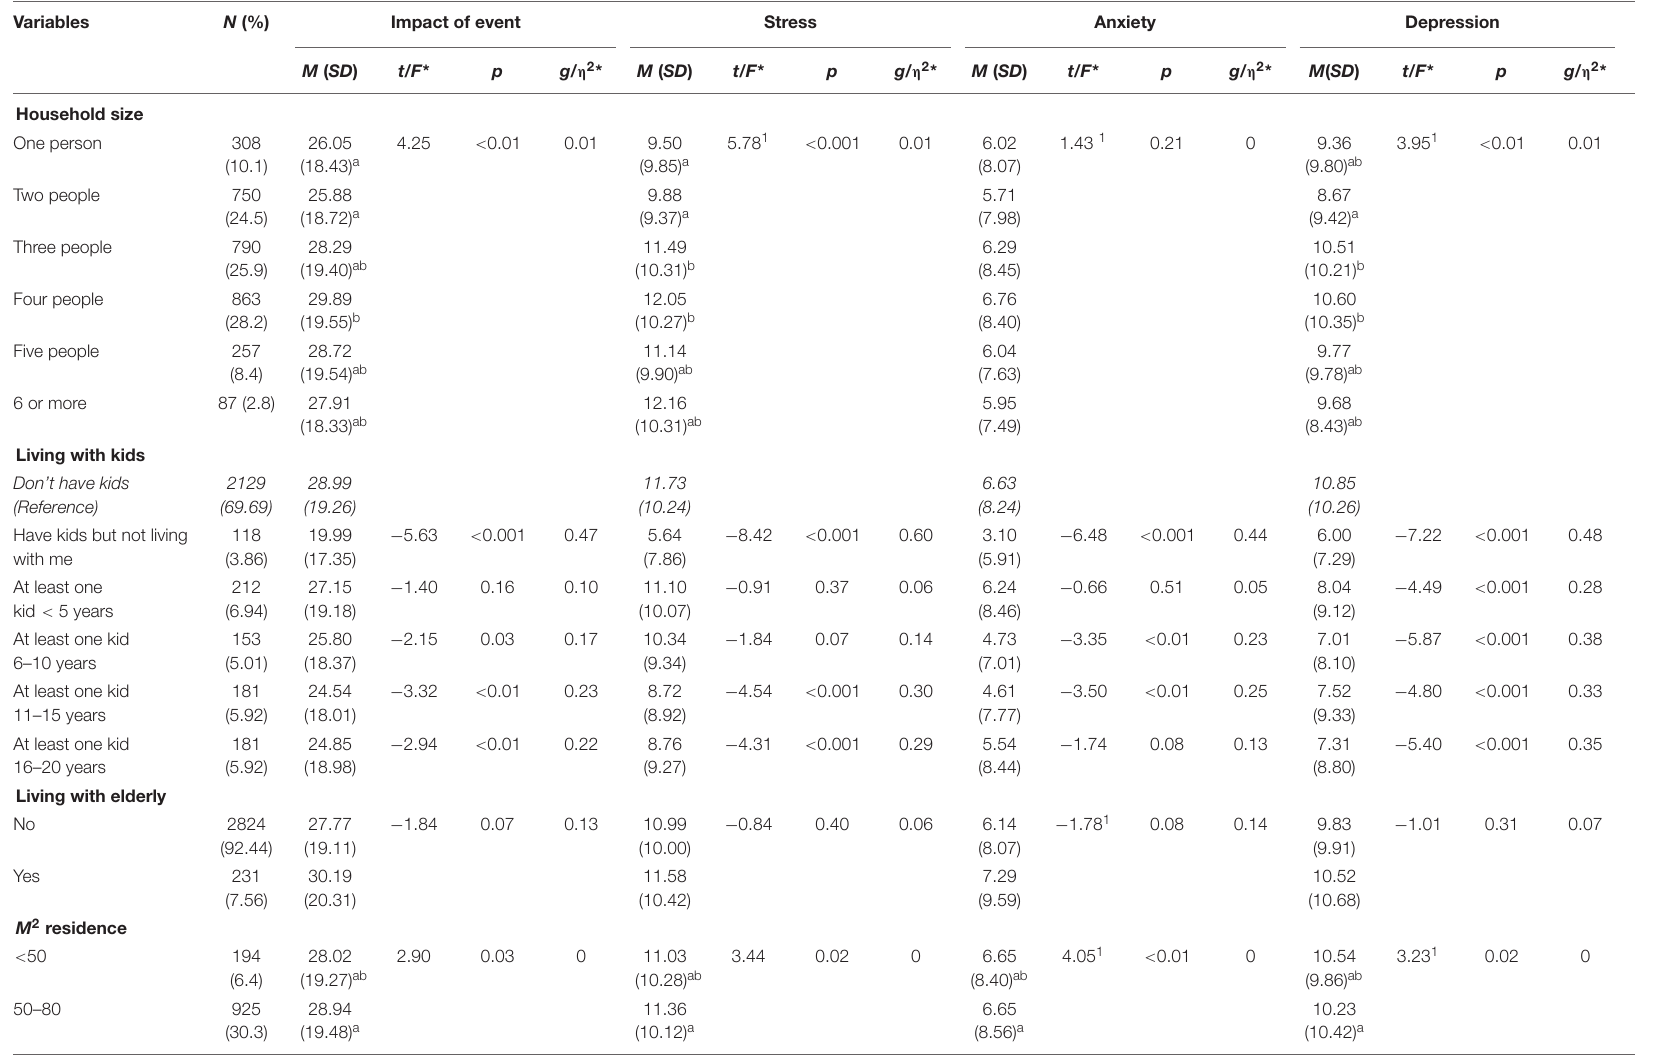
TABLE 4 | Association between living and environmental conditions during the home confinement and the psychological impact of the COVID-19 pandemic as well as mental health status during the pandemic ( N = 3055).